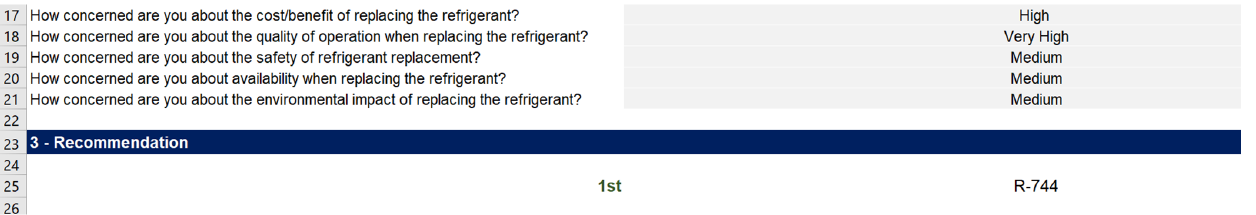
Figure 4. Solution of practical case one using average temperatures.